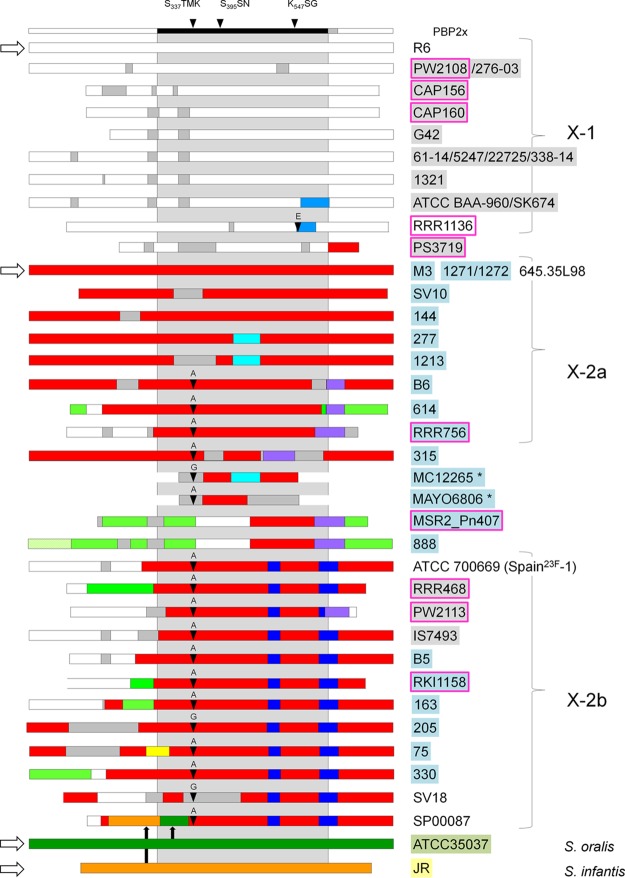
Mosaic structure of PBP2x variants. Mosaic gene structures were deduced by comparing the reference PBP2x sequences (white arrows on the left side) in S. pneumoniae R6 (white sequence blocks), S. mitis strains M3 (red), NCTC10712 (yellow), SV01 (light blue), and 658 (green), S. oralis ATCC 35037 (dark green), and S. infantis JR (orange). Highly similar sequences (<5% difference) are shown in the same colors; unrelated sequences of unknown origin are in gray. The domain structure and active site boxes of PBP2x are indicated on top; the gray shaded area indicates the central transpeptidase domain. Mutations at sites 338 and 552 are indicated by black arrows. The strains are indicated on the right and are shaded according to species: white, S. pneumoniae; light blue, S. mitis; gray, S. pseudopneumoniae; green, S. oralis; orange, S. infantis. A pink frame indicates isolates obtained from the GNRCS; four pbp2x from Jensen et al. (25) are indicated by an *.